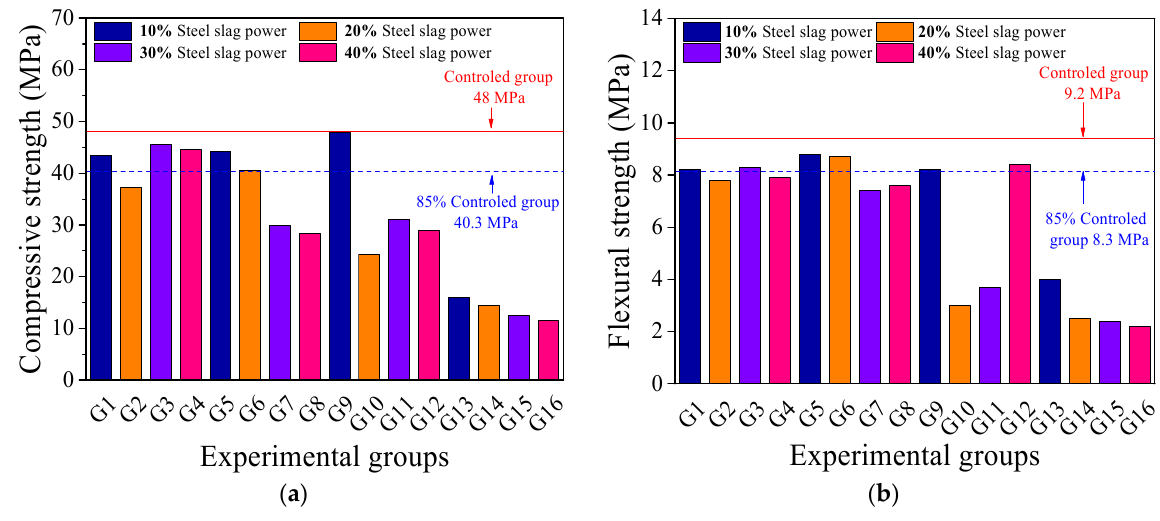
Figure 4. Strength of steel slag cement mortar with different mix proportions: ( a ) Compressive strength of experimental groups; ( b ) Flexural strength of experimental